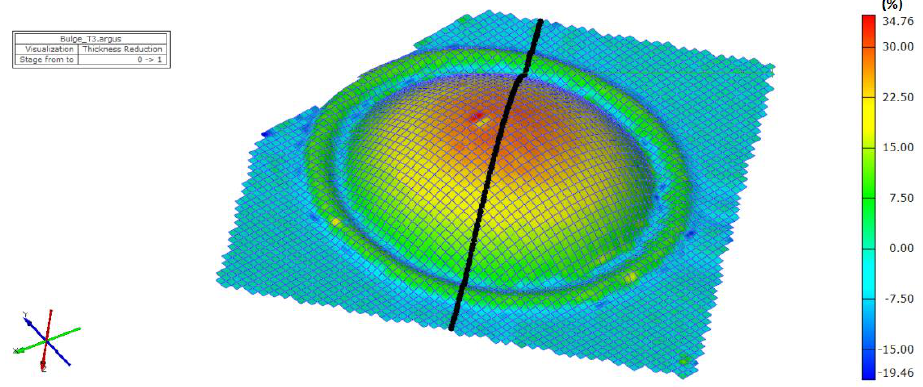
Figure 10. Material thickness values in 0° direction after bulge test evaluated by ARGUS system.